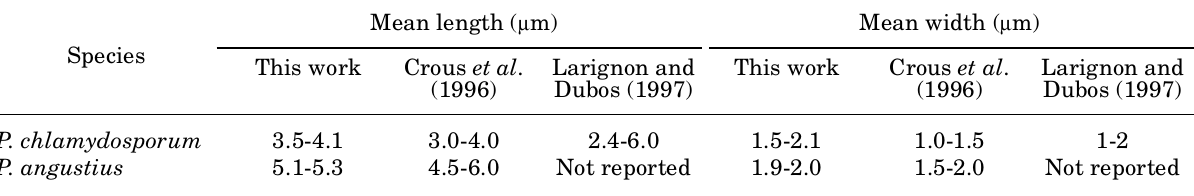
Table 4. Dimension of conidia of P. chlamydosporum and P. angustius. Comparison between our results and those reported in the